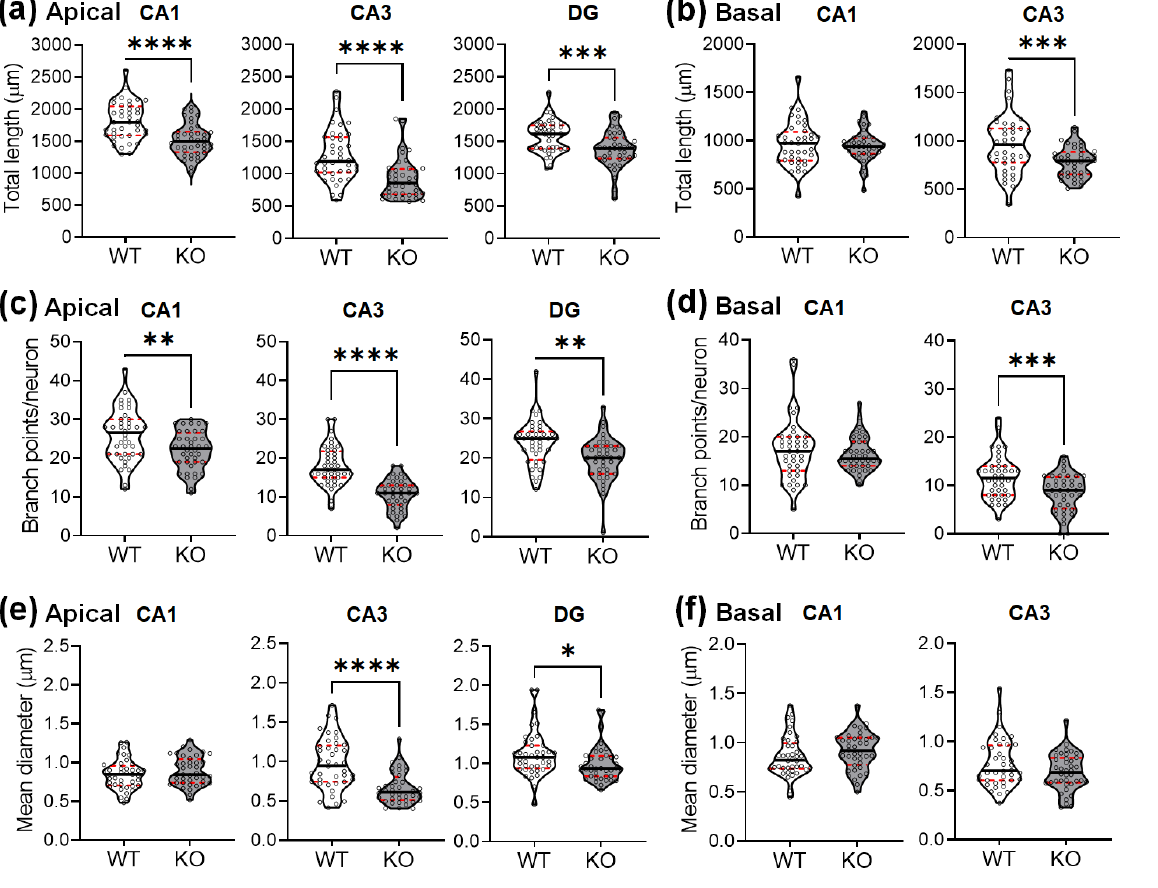
Figure 3. SREBP-1c KO mice show decreases in the length, number of branch points, and diameter of the dendrites in the hippocampus. Violin plots show the total length ( a , b ), number of branch points ( c , d ), and mean diameter ( e , f ) of the dendrites in each subregion (CA1, CA3, and DG). The upper and lower dashed red lines signify the upper and lower quartiles, respectively, and the median is represented by a solid black line within the violin plots. * p < 0.05, ** p < 0.01, *** p < 0.001, and **** p < 0.0001 vs. WT ( n = 40 dendrites/group). CA, cornu ammonis ; DG, dentate gyrus; WT, wild-type littermate; KO, SREBP-1c KO group.